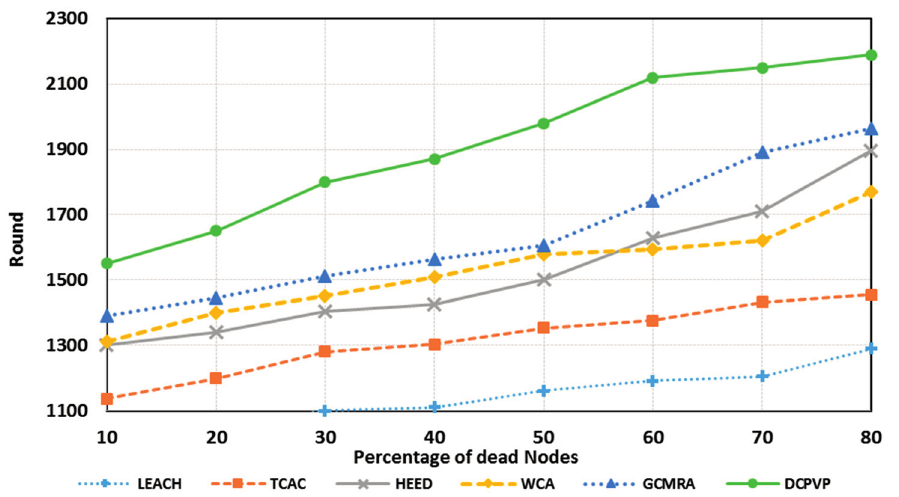
Figure 16. The percentage of dead nodes in random distribution for 250 nodes.